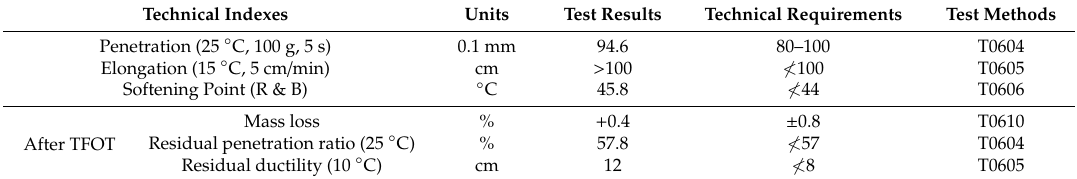
Table 1. Technical parameters of basic performances of SK90 asphalt.